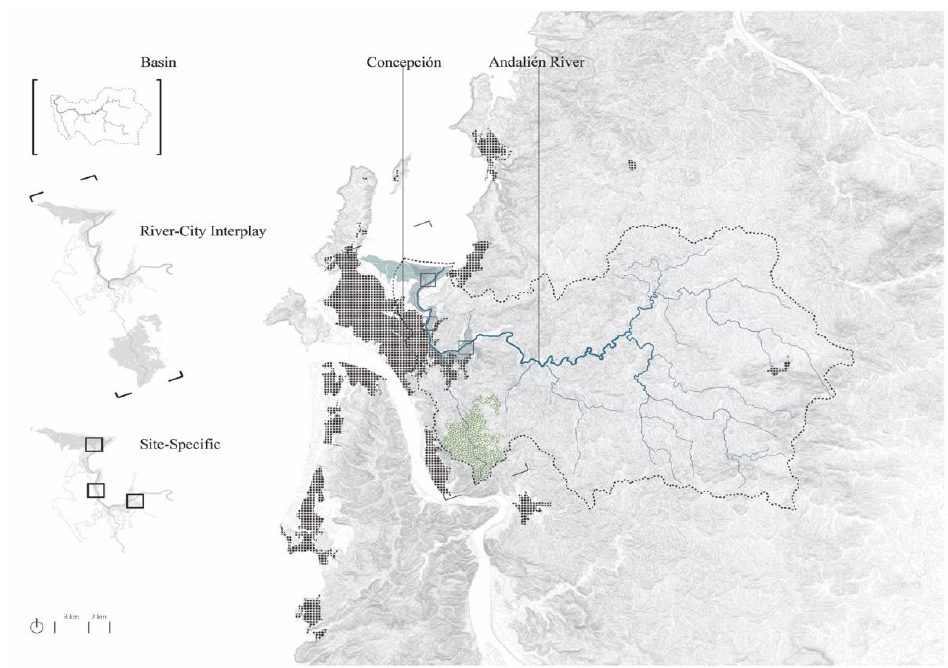
Figure 1. Concepción City and Andalién River location. Multiscale approach: Basin, river – city in- Figure 1. Concepci ó n City and Andali é n River location. Multiscale approach: Basin, river–city terplay and site specific. Source: Modified by the author Espinosa, 2020 in [52]. interplay and site specific. Source: Modified by the author Espinosa, 2020 in